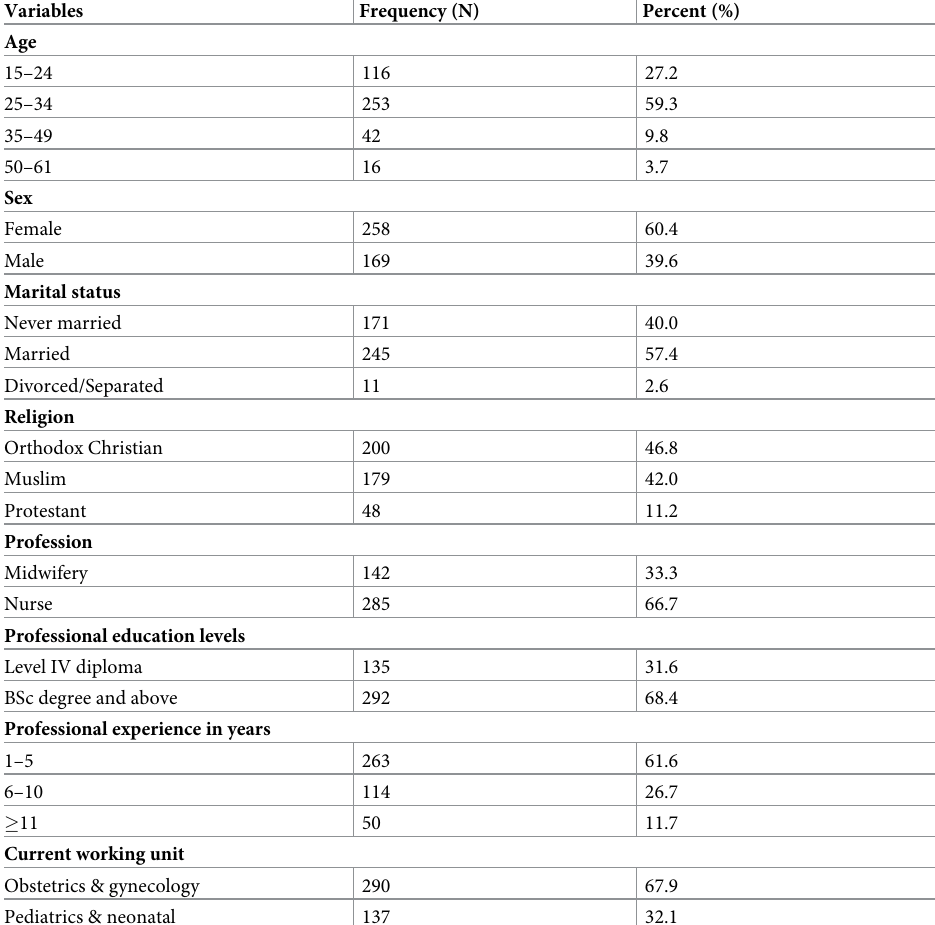
Table 1. Sociodemographic characteristics of study participants among midwives and nurses working in public health facilities in Eastern Ethiopia, November 2018 (n = 427).